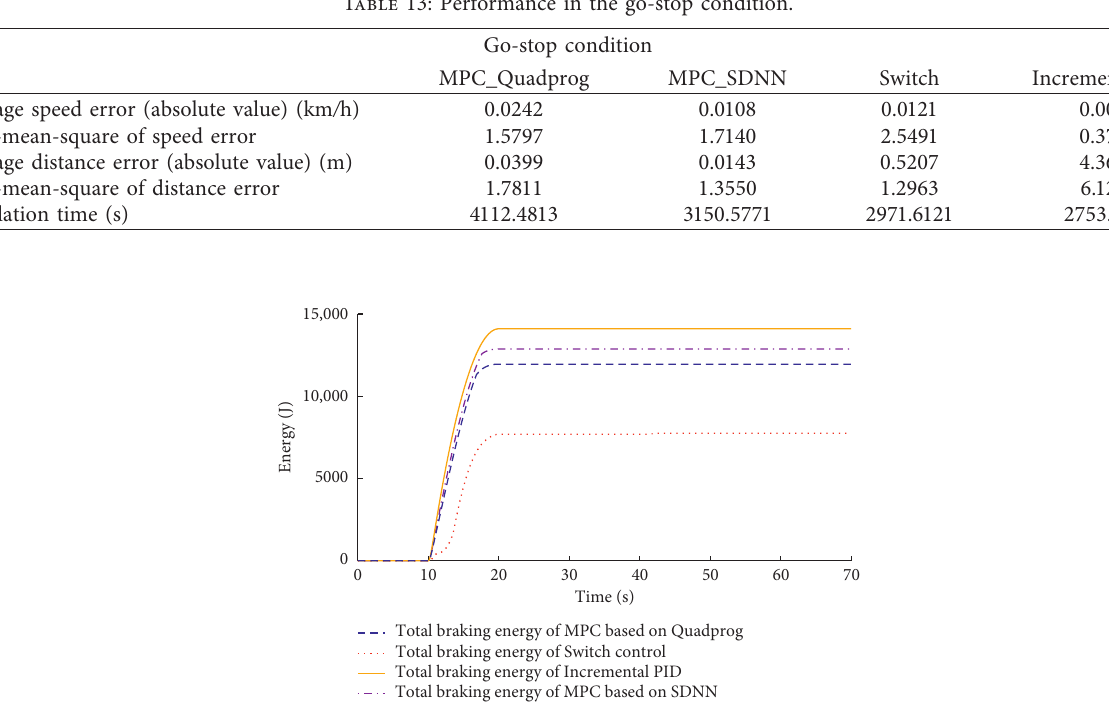
Figure 20: Total braking energy of four controllers.